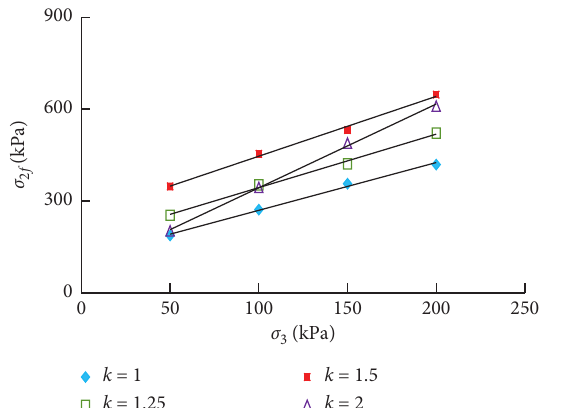
Figure 14: Change law between b